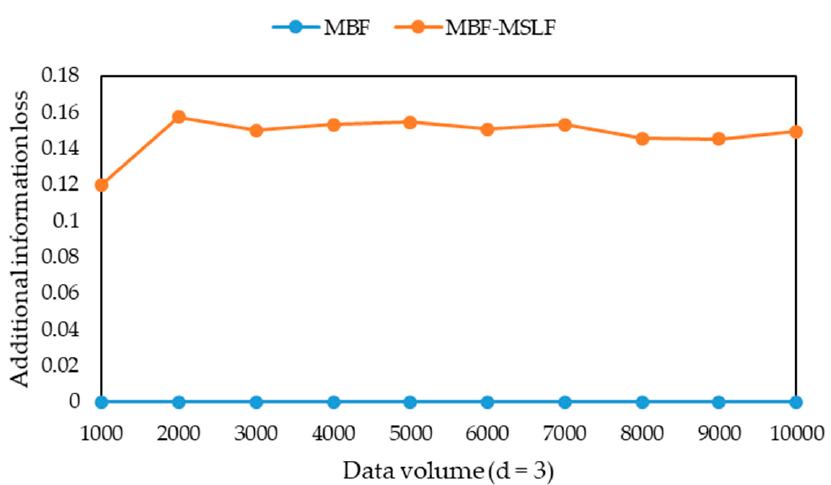
Figure 2. The additional information loss of maximal-bucket first (MBF) and MBF-maximal security- level first (MSLF) with different data volumes ( d = 3).